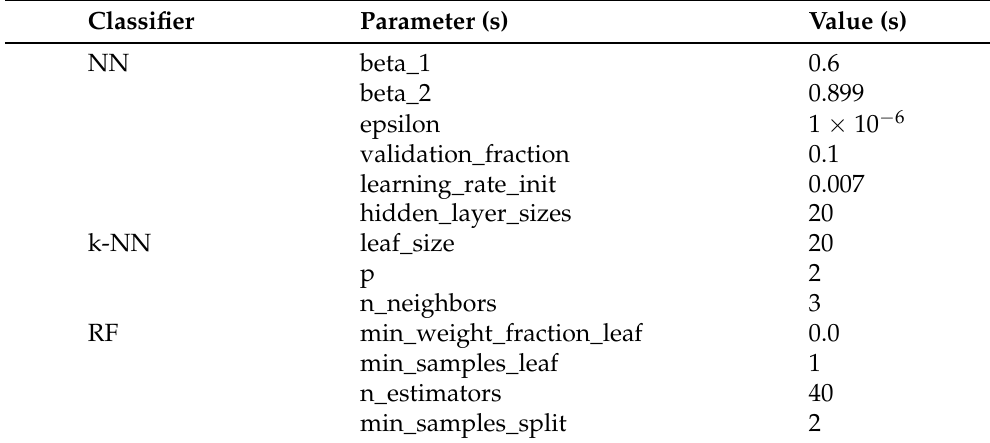
Table 9. Parameters of basic classification models.